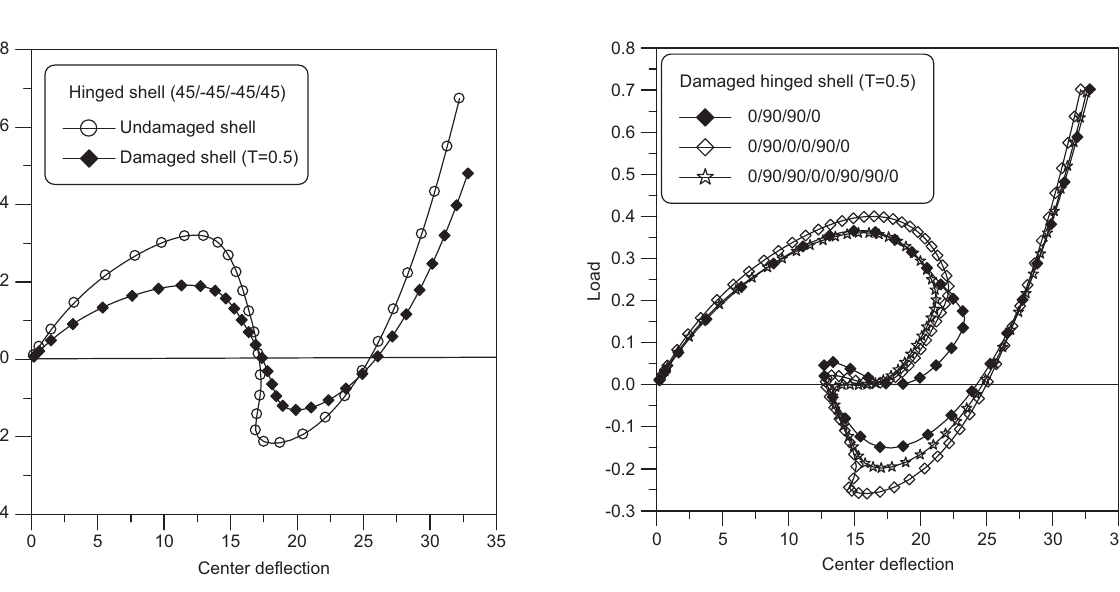
Figure 19 Load-displacement curves of hinged cylindrical